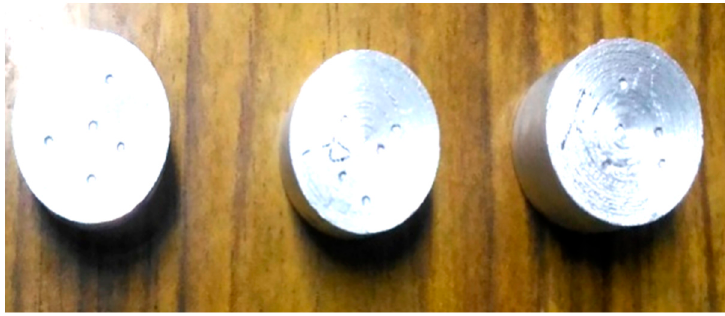
Figure 2. Hybrid composite specimens after hardness test.